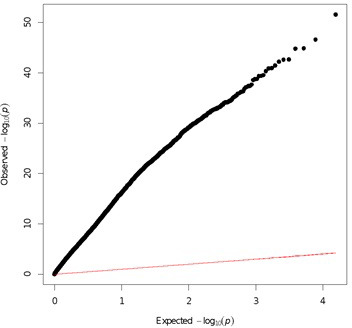
QQ plot demonstrating a significant shift away from the null represented by the red line of no difference between individuals as determined by assessing intra-individual variance from the biologic replicate samples.